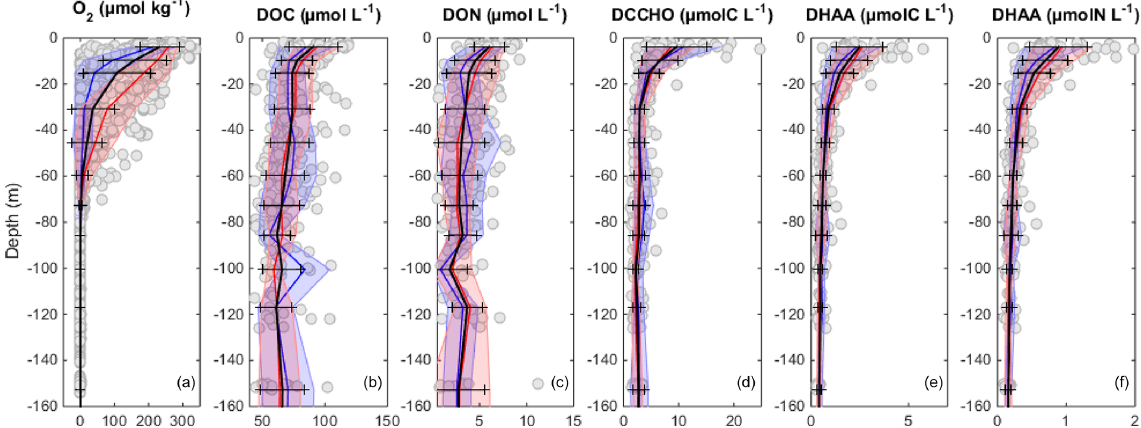
Figure 4. Vertical distribution of O 2 (a) , DOC (b) , DON (c) , DCCHO(C) (d) , DHAA(C) (e) , and DHAA(N) (f) . Black line and error bar represent mean distribution and standard deviations of the data points (grey circles), respectively. The blue and red lines and shaded areas represent the mean distributions and standard deviations of parameters onshore ( < 40km) and offshore ( > 40km),